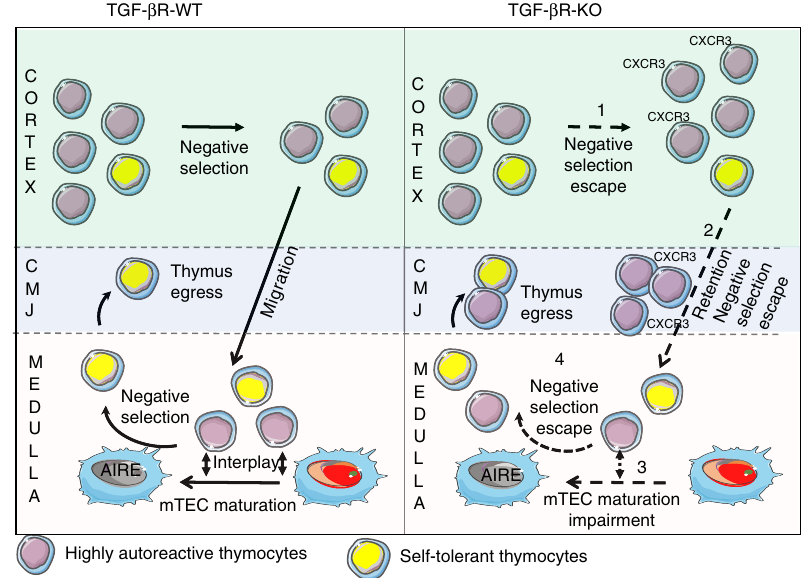
Fig. 7 Schematic overview of the multiple effects of TGF- β on negative selection. In the absence of TGF- β signaling, highly autoreactive thymocytes escape cortical negative selection ( 1 ). They then acquire CXCR3 at their surface and a large fraction of them are trapped at the CMJ (cortico-medullary junction) ( 2 ), preventing their entrance in the medulla where a second wave of negative selection occurs. The few highly autoreactive thymocytes entering the medulla fail to condition mTECs for an ef fi cient negative selection: AIRE pos mTEC differentiation is largely altered as well as their ability to express TRA ( 3 ). Highly autoreactive thymocytes escape the second wave of negative selection ( 4 ). In sum, in the absence of TGF- β signaling control in thymocytes, several mechanisms essential for elimination of highly autoreactive thymocytes are impaired in the thymus allowing them to reach the periphery where they can induce tissue damage. The fi gure has been created by